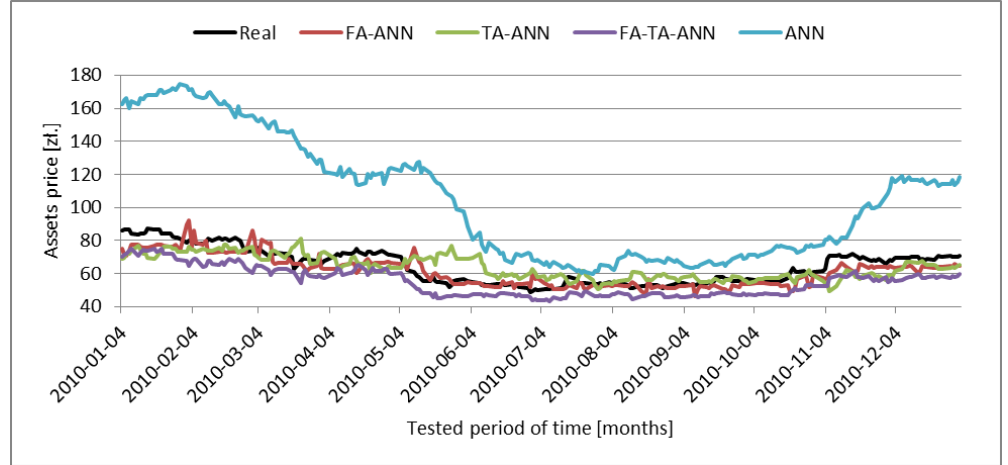
Figure 3. Short-term forecast of ANN-based models and the real CLOSE value for BPH Bank SA in 2010.